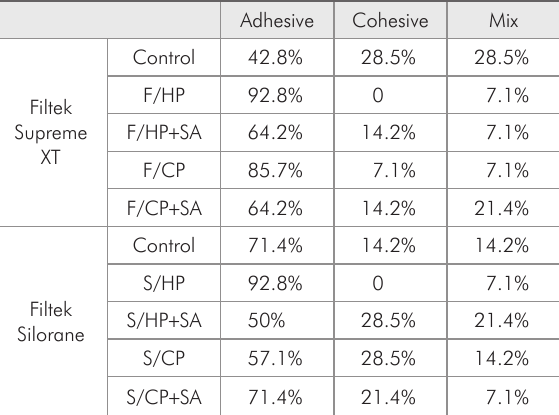
Table 3 - Failure modes of fractures.